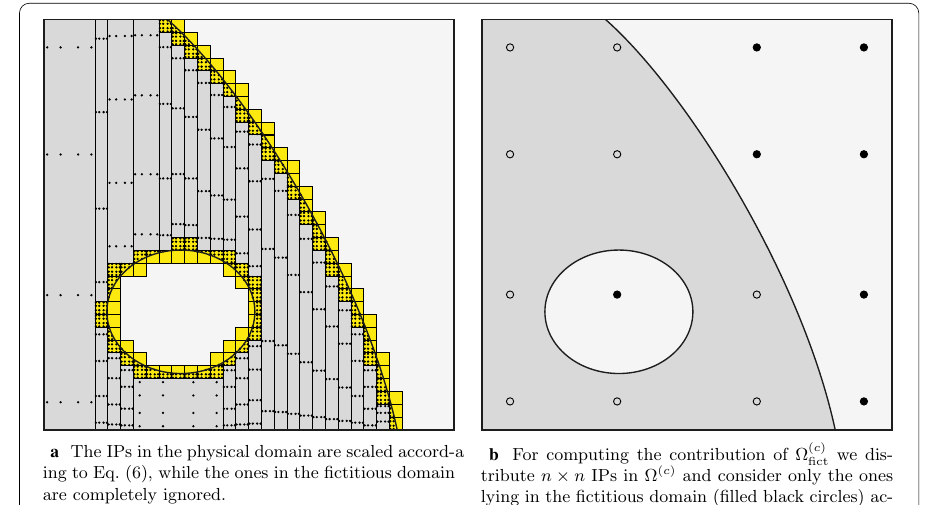
sub-cells are created, whose Boolean meta information by the labels α B = 1 and α B = − 1 are utilized during numerical integration. For more in depth introduction please see the original work [45]. Throughout the current contribution we refer to such a way of con- structing the LIM as B-QTD , while the term B-FCM is used for the entire simulation, including both the B-QTD and the corresponding numerical integration. The set of sub- cells resulting from the B-QTD is denoted by B . Due to the fact that the B-FCM yields the same results as the FCM but with a reduced number of IPs, the B-FCM can be